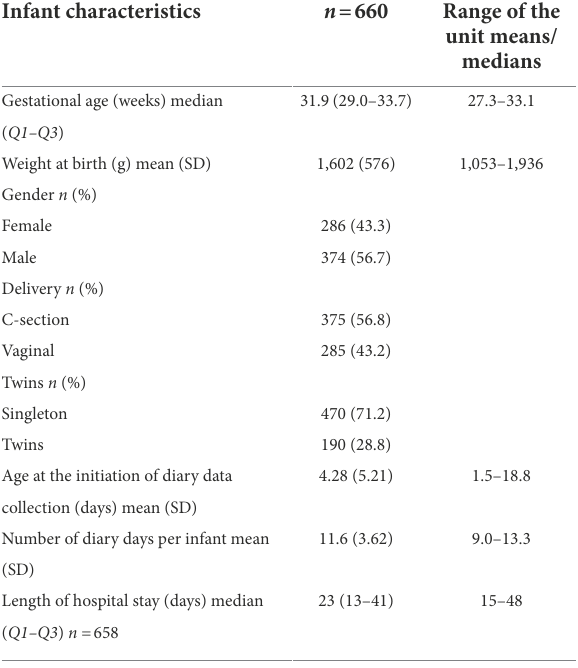
TABLE 2 Infant background characteristics and the initiation and length of diary data collection in the final study group as a whole and the lowest and highest means/medians of the units.